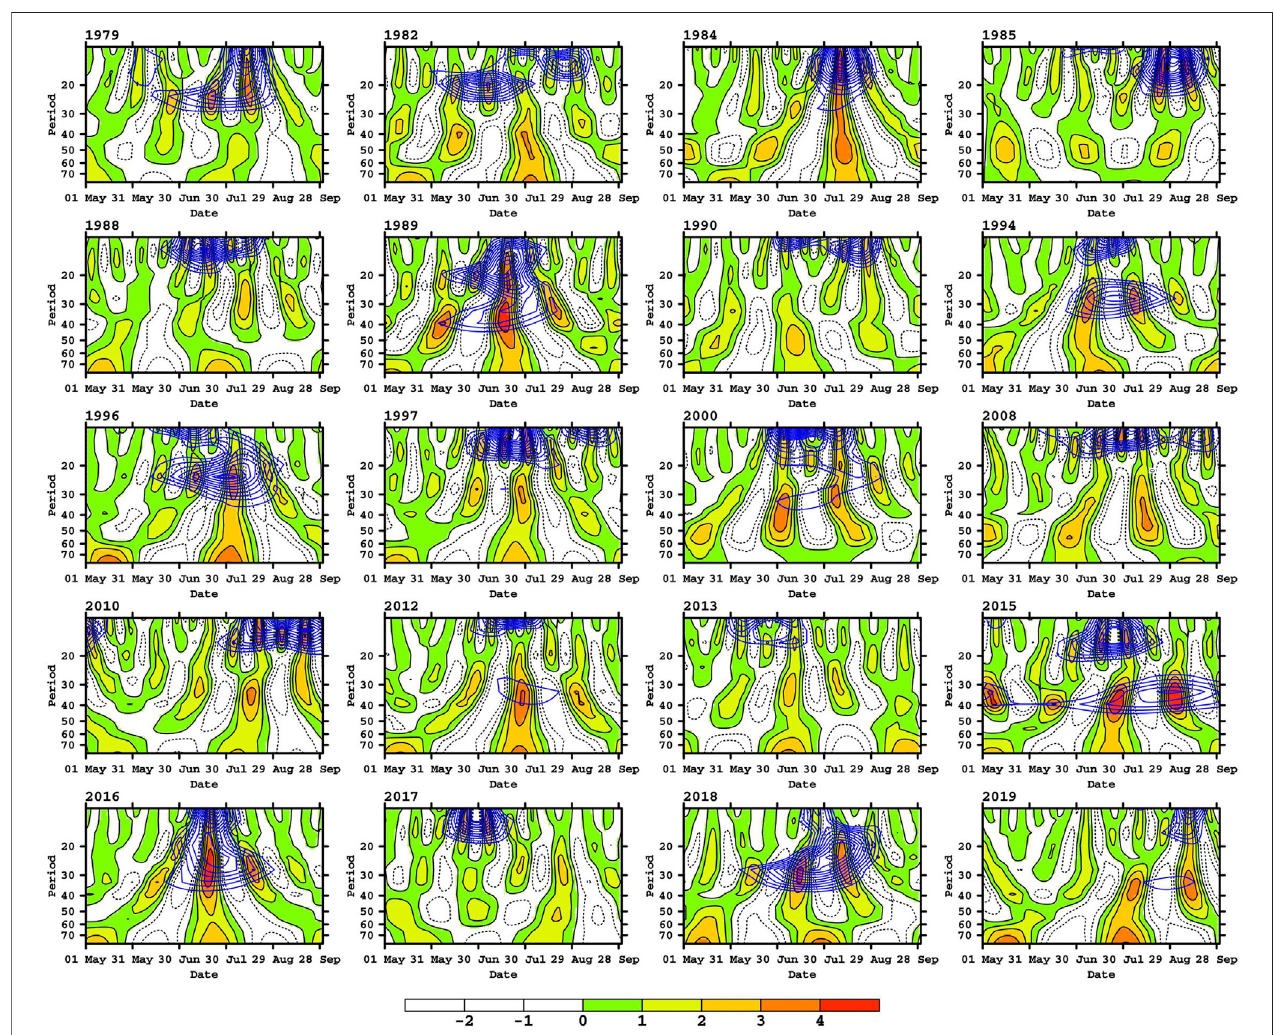
FIGURE 2 | Wavelet analysis of regional daily precipitation from May to September in years that PEPEs occur, blue contour areas denote which periods are signi fi cant at the 95% con fi dence level.